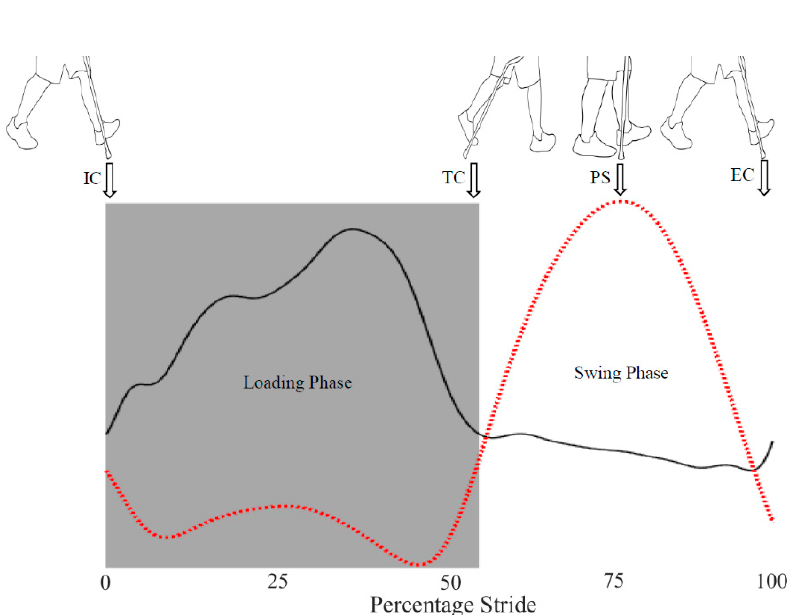
Figure 3. IC, TC and EC events corresponding to strain gauge data (solid black line); PS event corresponding to peaks in gyroscope AP velocity (dotted red line).